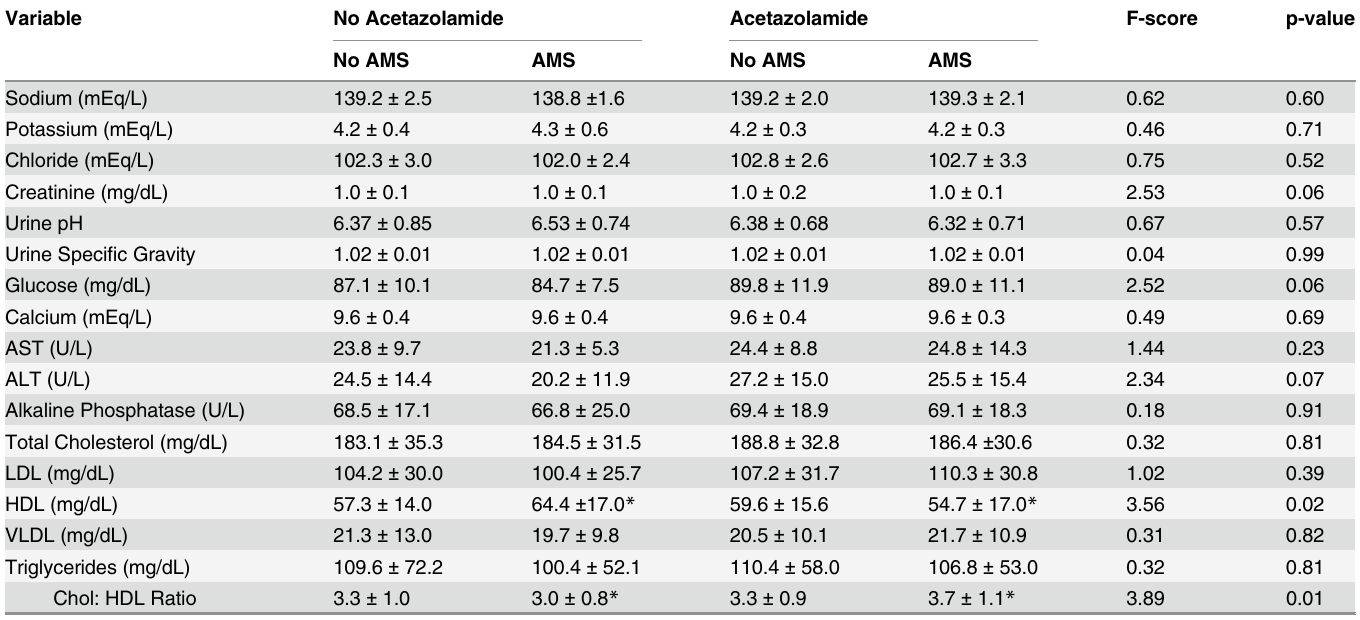
Table 2. Biochemical Variables.